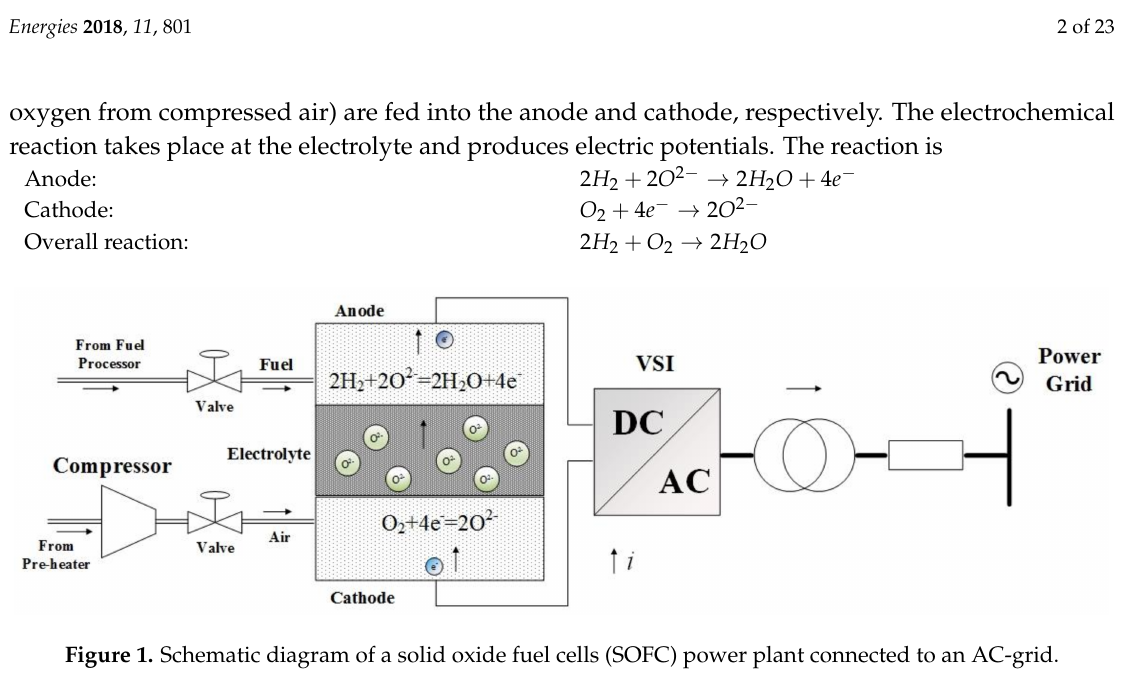
Figure 1. Schematic diagram of a solid oxide fuel cells (SOFC) power plant connected to an AC-grid. When the circuit loop is closed, the reaction proceeds to output electric power to the external load. In practice, SOFCs are usually connected to a micro power grid through voltage source invertors (VSI) for DC-AC transformation. In the grid level, the dispatching system is working to generate load demand signals to the power sources that are connected to the grid. These power sources make response to the load demands, thus the energy are balanced in the power grid and the frequency are maintained [6]. Consequently, for grid-connected SOFCs, its output power should track the unit load demand from the dispatching system. With this operation mode, the control problem considered for a grid-connected SOFC lies